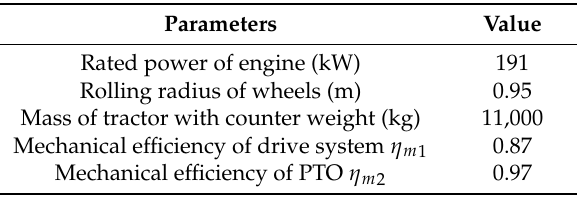
Table 2. Basic parameters of the objective tractor.